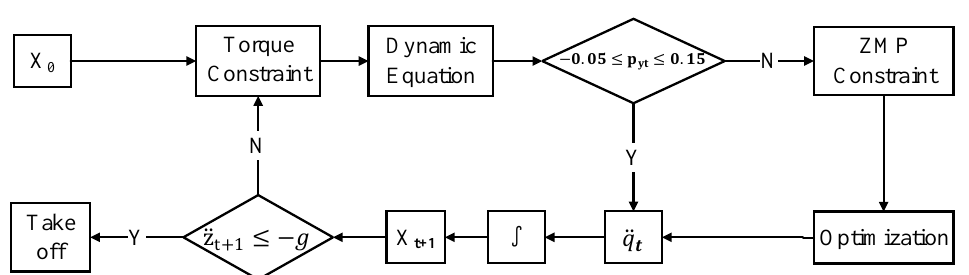
Figure 8. The joint constraint is removed. The torque constraint is used to ensure that all three joint torques yield the torque speed curve profile. Furthermore, the ZMP constraint is used to keep the dynamic balance throughout the entire puss-off phase.